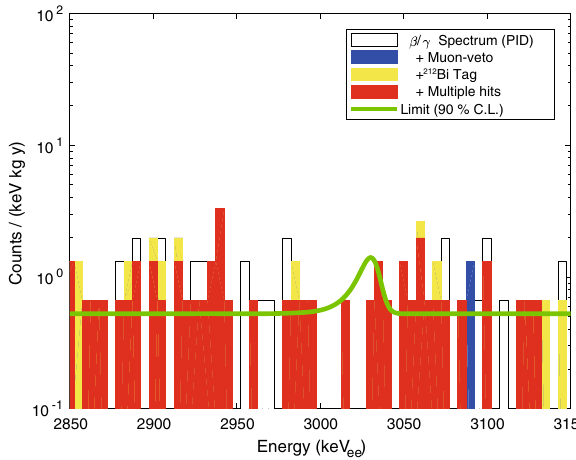
Fig. 7 Theenergyspectragatheredby 48depl Ca 100 MoO 4 detectorswith the 111 kg day exposure in the ROI before and after applying coinci- dence tagging techniques. Each spectrum represents the result after the cut criterion overlaying the previous accumulation. The solid green line is the fitted response function describing the flat background and the excluded 0 νββ peak corresponding to the 90% confidence level (C.L.) Table 4 α activity levels in the Pilot crystals. The limits are for